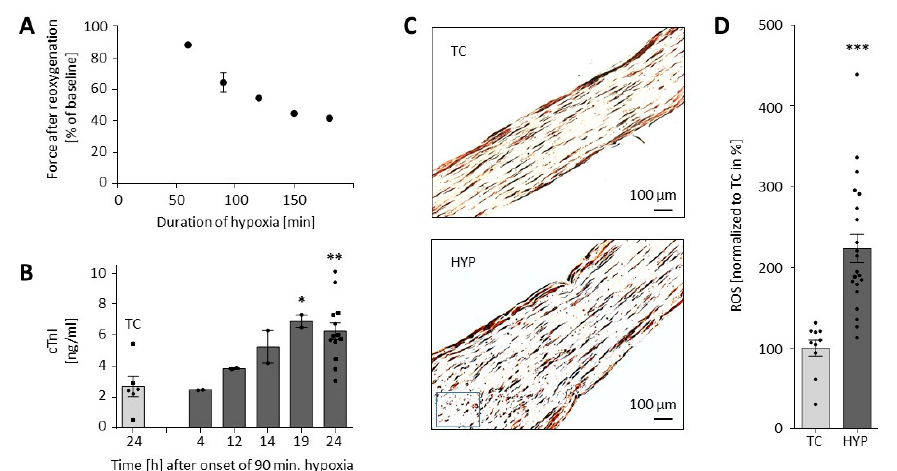
Figure 2. Model of hypoxia-reoxygenation injury in rat-engineered heart tissues (EHTs). ( A ) Correlation between duration of hypoxia and decrease in force after 120 min of reoxygenation (each dot represents the mean force of one batch of EHTs ( n = 8–12), except for 90 min where hypoxia experiments from 9 independent batches were averaged (mean ± SEM). ( B ) Release of cardiac troponin I (cTnI) over 24 h after the onset of hypoxia (90 min) compared to the time control (TC) group. Data are presented as scatterplot with mean (bars) ± SEM (whiskers). One-way ANOVA with Dunnett‘s post-hoc test ( n = 2–13, each measurement from the pooled cell culture media of 2 EHTs; “19 h” vs. “TC”, * p = 0.029; “24 h” vs. “TC”, ** p = 0.002). The values depicted as circles stem from one experimental series. ( C ) MLC-2V (myosin light chain 2, ventricular isoform) staining of EHTs undergoing 90 min of hypoxia and reoxygenation (HYP) and control group without hypoxia (time control = TC). In some central areas of the hypoxic EHTs (e.g., at the blue rectangle) only roundish cardiomyocytes were detectable. ( D ) Reactive oxygen species (ROS) measured in the cell culture media of TC and HYP groups. Student’s unpaired t-test ( n = 10–21 per group, *** p < 0.0001). 3.2. Preconditioning of EHTs by Brief Episodes of Hypoxia We exposed rat EHTs to 90 min of hypoxia in lactate medium. In the treatment group, the EHTs underwent three cycles of 10 min short hypoxic preconditioning (group “HPC”). Figure 3A shows that contractile force in both groups decreased during hypoxia and increased during early reoxygenation (0–2 h) to a similar extent. In the follow-up period (late reoxygenation, ≥ 2 days) the force was preserved only in the group of the preconditioned EHTs. Cardiac troponin I levels in the medium were significantly lower in the HPC group (Figure 3B). We measured the oxygen fraction of the gas dissolved in the medium depending on the input gas flow into the contractility measurement system. The oxygen fraction in the medium (Figure 3C) was highly dependent on the inflow rate and considerably lagged behind the O 2 -fraction in the air. The forces of the EHTs (Figure 3D) reflected this tardy decrease in the O 2 -fraction in the medium under the low-flow more than under the high- flow rate. We thus used a consistent protocol in all following experiments with a high-flow rate for the first 10 min of hypoxia to ensure the fast decrease in the O 2 -fraction in the medium and then returned to the low-flow rate to maintain the oxygen mixture.